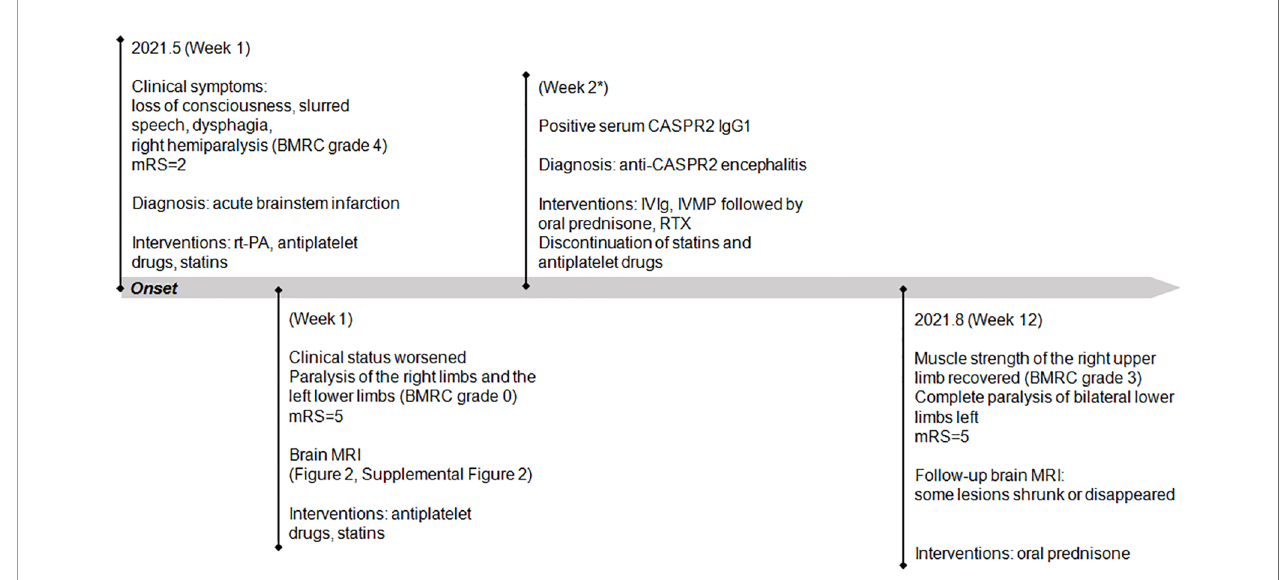
FIGURE 4 | Timeline of patient 2 with relevant data of the past episodes and interventions. *This admission. mRS, modi fi ed Rankin scale; IVIg, intravenous immunoglobulin; IVMP, intravenous methylprednisolone; RTX,